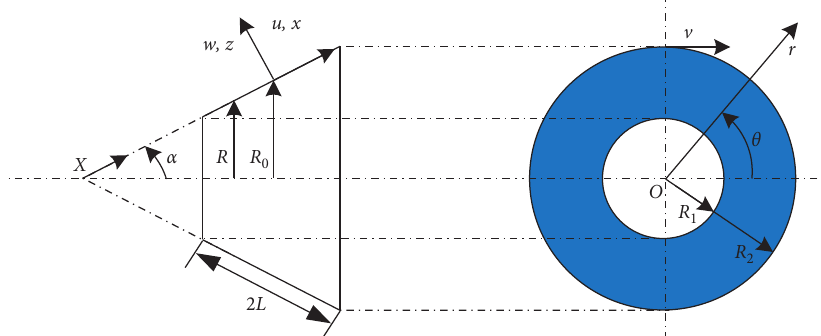
Figure 1: Sketch of geometry and coordinate system of the conical